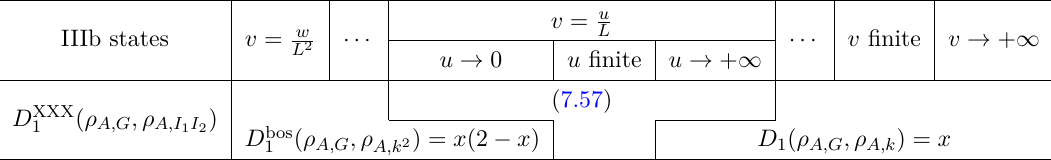
Table 2 . The subsystem trace distance between the ground state and the case IIIb double-magnon bound state in XXX